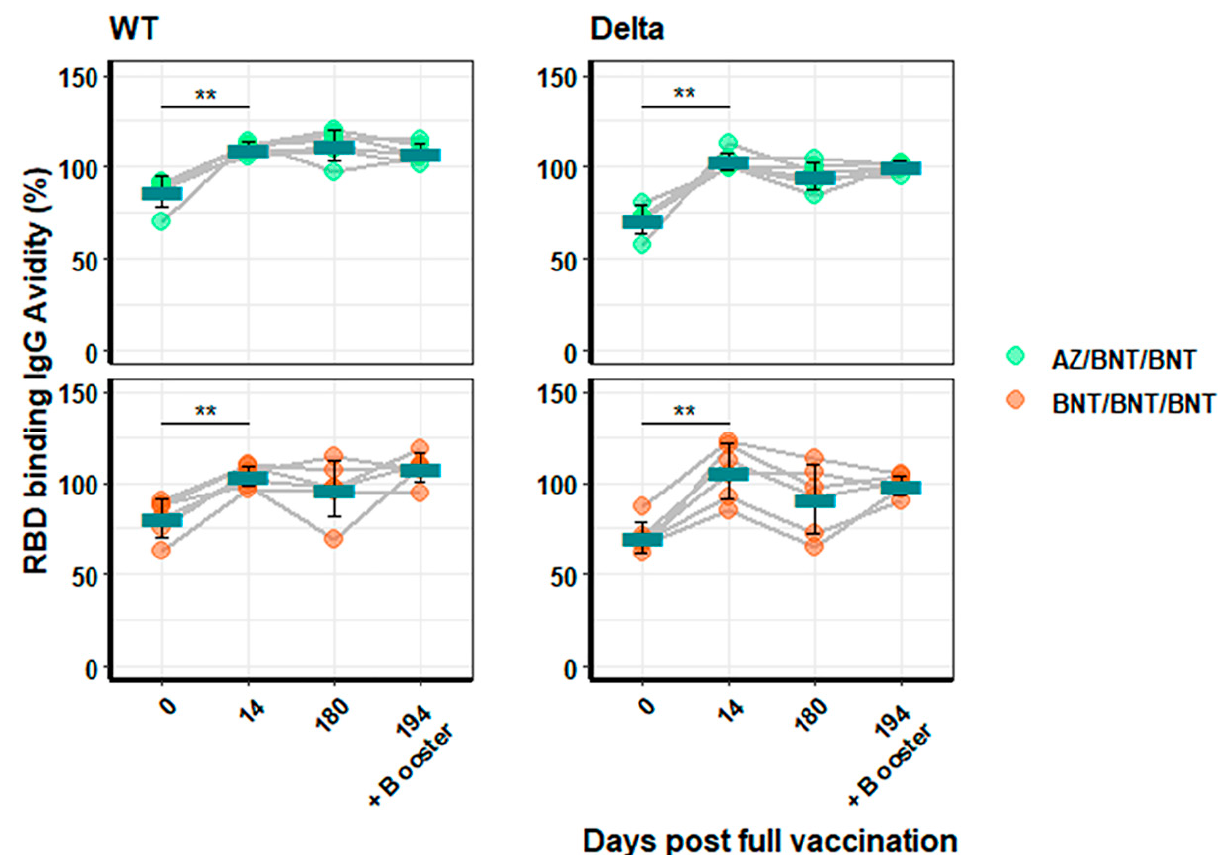
Figure 5. Analyses of IgG avidity to RBD in sera from heterologous or BNT-vaccinated individ- uals . Depicted are IgG avidity measurements for WT- and Delta-RBD binding from individuals vaccinated AZ/BNT/BNT (green) and BNT/BNT/BNT (orange) immunization schedules. Blood was collected at 0, 14, and 180 days post full vaccination and, additionally, 14 days after the booster immunization. Omicron-RBD avidity could not be determined, because it was below background values. Turquoise bars indicate the arithmetic mean for each group. Significance is indicated with two stars (**) for a p -value between 0.001 and 0.01, and one star (*) denotes a p -value between 0.01 and 0.05. A similar pattern to that observed for antibody binding was also found for neutraliz- ing antibodies. The second vaccination increased the amount of neutralizing antibodies directed against WT- and Delta-pseudotyped vectors, with BNT/BNT showing two- to three-fold higher neutralization (mean 1/AUC = 7.71 ± 4.72 for WT and 2.51 ± 2.17 for Delta) (Figure 6) at 14 days after the second vaccination than AZ/BNT-immunized indi- viduals (mean 1/AUC = 3.33 ± 2.17 for WT and 1.50 ± 0.63 for Delta). At six months, the neutralization activity against WT and Delta decreased to very low levels (mean WT: AZ/BNT 1.22 ± 0.76 and BNT/BNT 0.80 ± 0.32). However, it was increased by the booster vaccination to similar or slightly higher levels compared to 14 days after the second vac- cination. The heterologous vaccination always produced lower values than the mRNA vaccinations (mean 3.70 ± 1.18 versus 4.35 ± 1.37, respectively). Neutralization of Omicron was virtually absent in all samples, except for those taken after the booster vaccination. No difference in Omicron-specific neutralization activity could be detected between the vacci- nations in the final booster values (mean 1.10 ± 0.81 for AZ/BNT/BNT and 1.12 ± 0.70 for